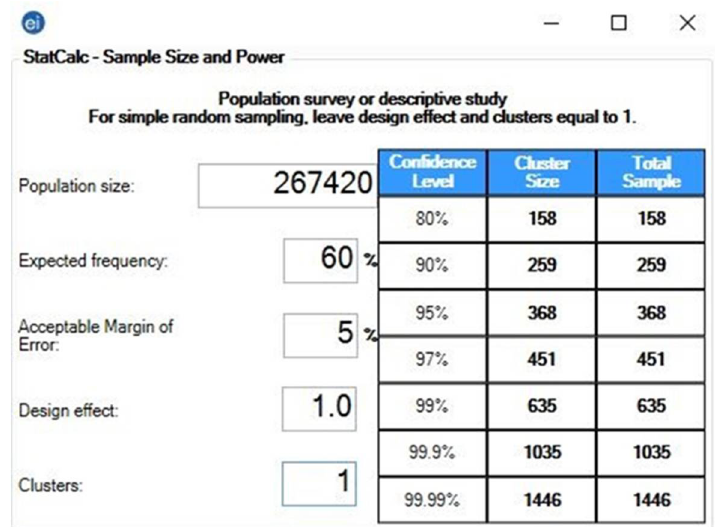
Figure 1. Sample size of healthcare workers (HCWs) in the Czech Republic—Epi-Info TM version 7.2.4. Population size: Total number of healthcare workers in the Czech Republic in 2017 [30]. Expected frequency: The overall prevalence of side effects following COVID-19 vaccines ranged between 62% and 93%; therefore, 60% was assumed as a threshold. Acceptable margin of error: The permissible level for all CoVaST groups will be 5%. Design effect: One—per the recommendation of the CDC for simple sampling [29]. Clusters: One—per the recommendation of the CDC for simple sampling [29]. The pragmatic sample size is 368–635 (CI 95%–99%).